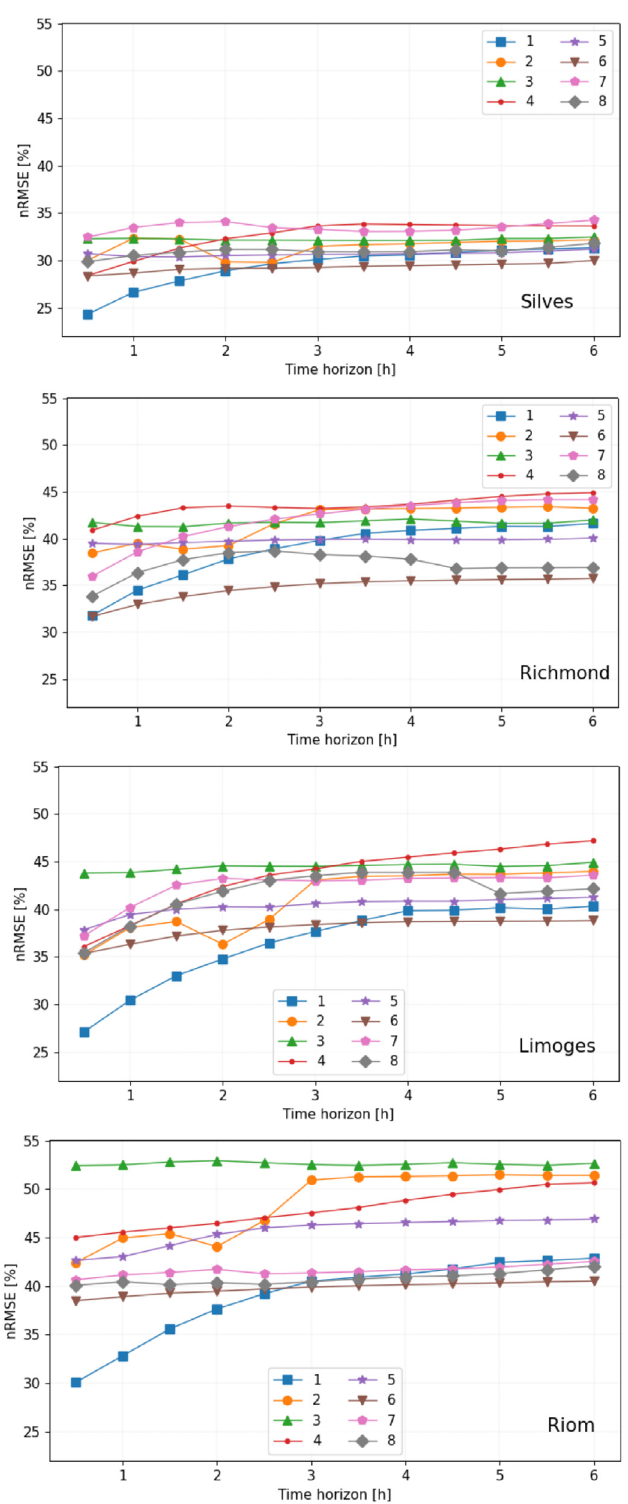
Fig. 4. nRMSE as a function of forecast horizon for all participants and for Silves, Richmond, Limoges and